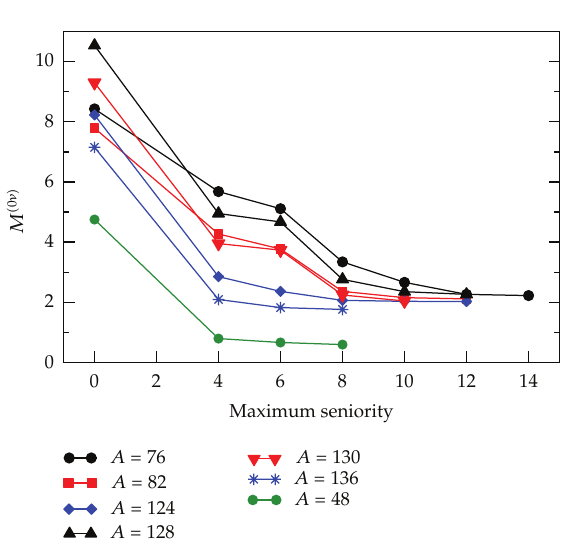
Figure 4: (cid:2) Color online (cid:3) The neutrinoless double-beta decay NMEs as a function of the maximum seniority allowed in the wave